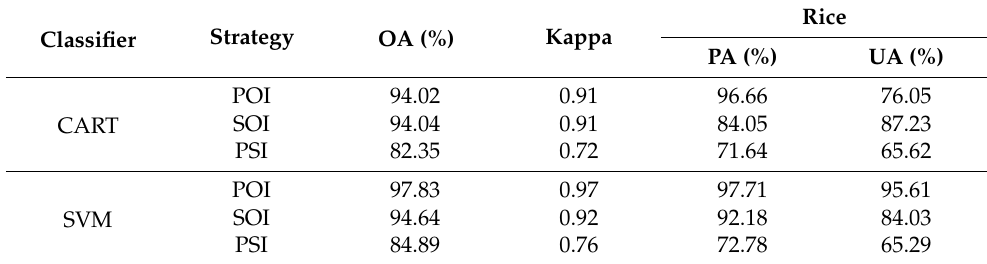
Table 7. Accuracy of rice mapping under different strategies.